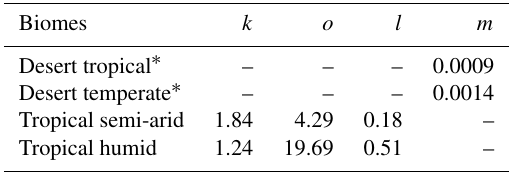
Table A3. Parameter values for cumulative precipitation functions in Eq. (A2) for the tropical biomes and Eq. (A3) for the desert